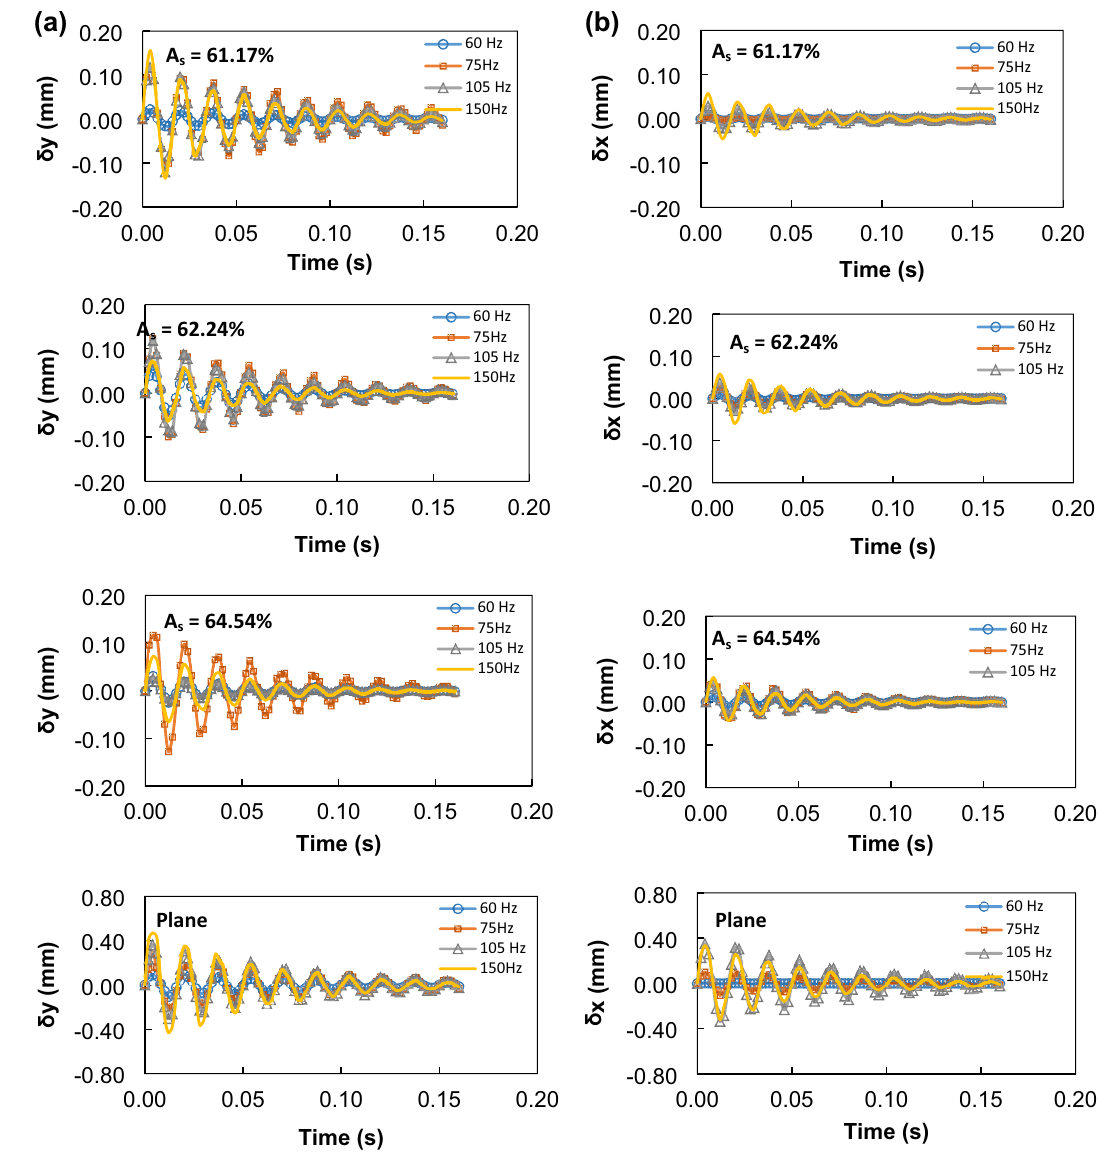
Figure 8. ( a ) Maximum vertical displacement of the droplet with time at different sonic excitation frequencies for different mesh screen open aperture ratio ( A s ) and plane hydrophobic surface after shot-off sonic excitation. ( b ) Maximum horizontal displacement of the droplet with time at different sonic excitation frequencies for different mesh screen open aperture ratio ( A s ) and plane hydrophobic surface after shot-off sonic